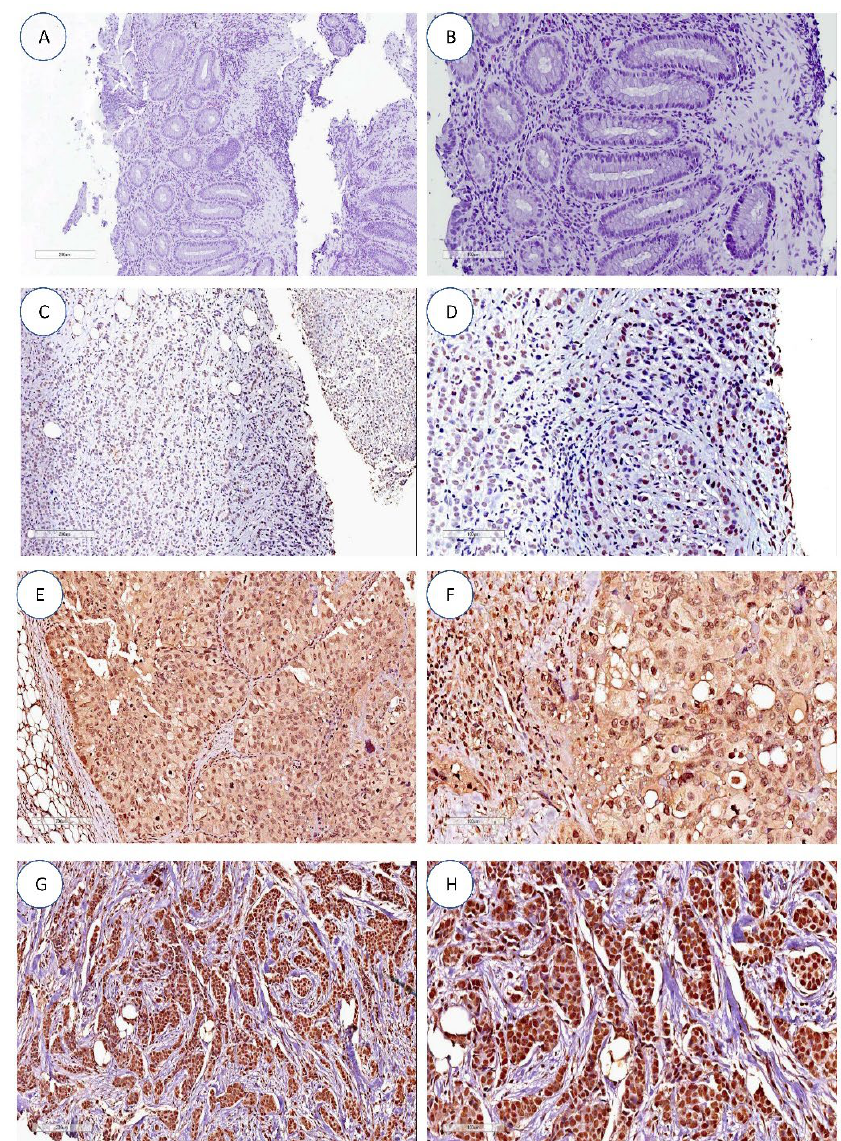
Figure 1. hTERT expression by immunohistochemistry. ( A ) and ( B ) Negative controls. ( C ) and ( D ) Absence of hTERT nuclear and cytoplasmic staining in infiltrating ductal breast carcinoma. ( E ) and ( F ) Predominant nuclear hTERT staining (grade 3) in infiltrating ductal breast carcinoma. ( G ) and ( H ) Diffuse cytoplasmatic and nuclear hTERT staining (grade 3) in infiltrating ductal breast carcinoma. All images are at 10× and 20× magnification. Table 3. Exclusive and concomitant expression detailing of hTERT between nucleus and cytoplasm.